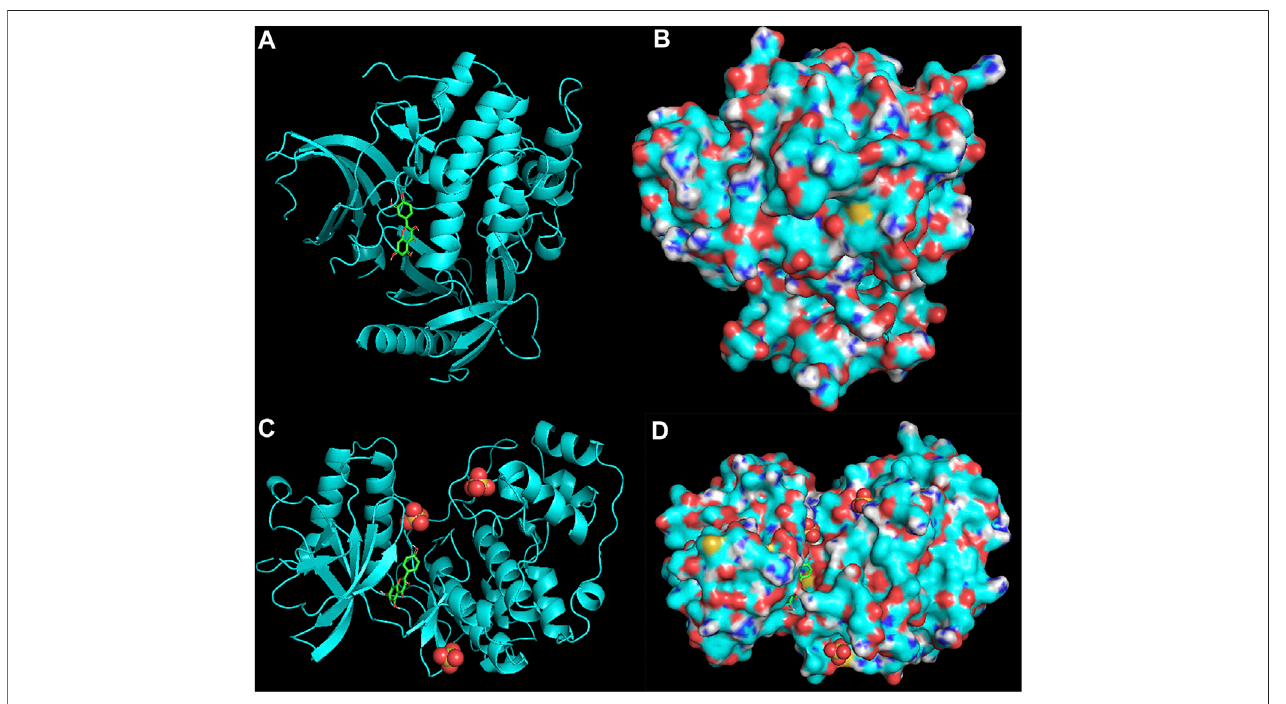
FIGURE 7 | AKI protein: luteolin (A,B) and MAPK1 protein: kaempferol (C,D)